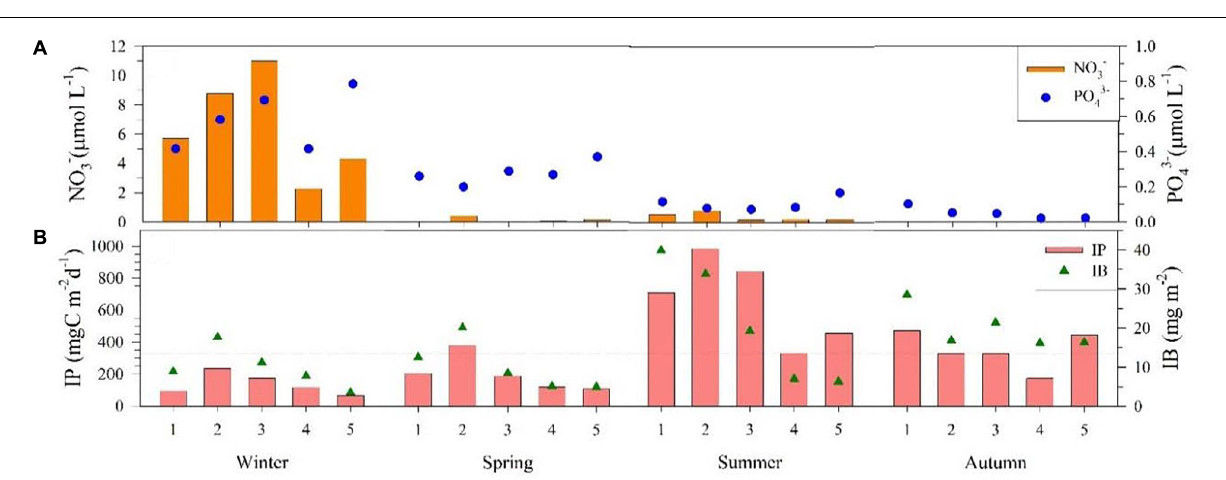
important parameter regarding the health of ecosystem (Lee et al., 2007). The inshore station (station 5) had the shallowest water depth, so the water column was easily affected by terrestrial inputs or resuspend particles from the sediment, especially during the winter (Naik and Chen, 2008). As a result, the relatively shallow euphotic zone depth was observed at station 5 throughout all